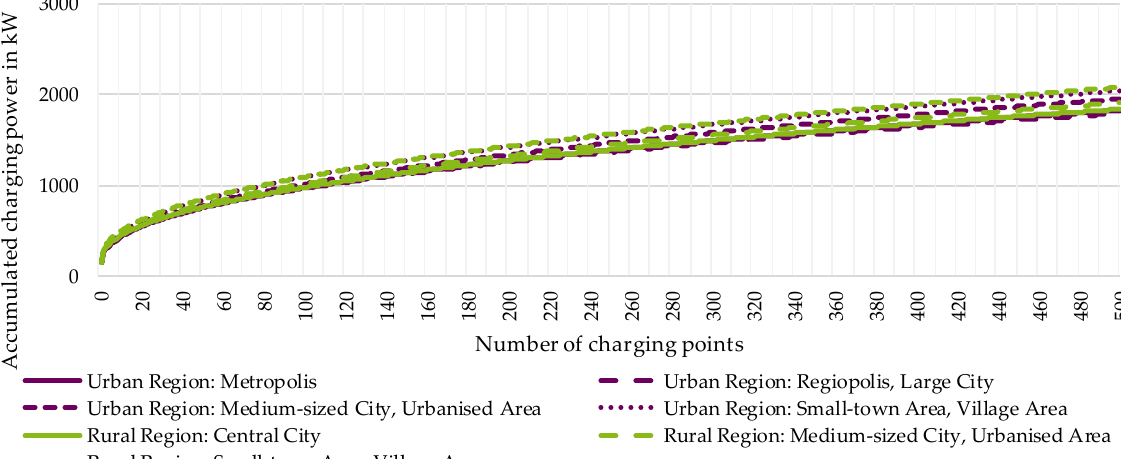
Figure A8. Accumulated charging power in kW for 150 kW charging points up to 500 charging points for seven area types.